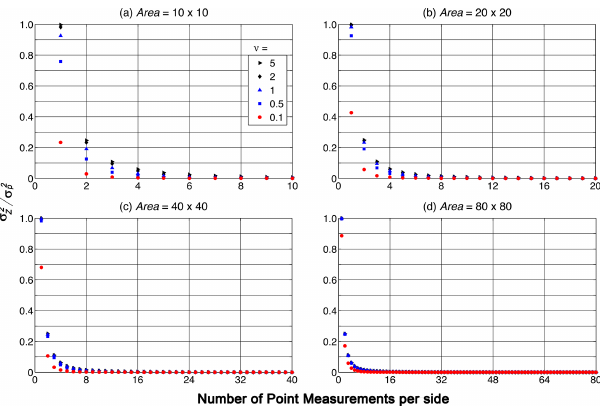
. σ 2 p ) for the Z